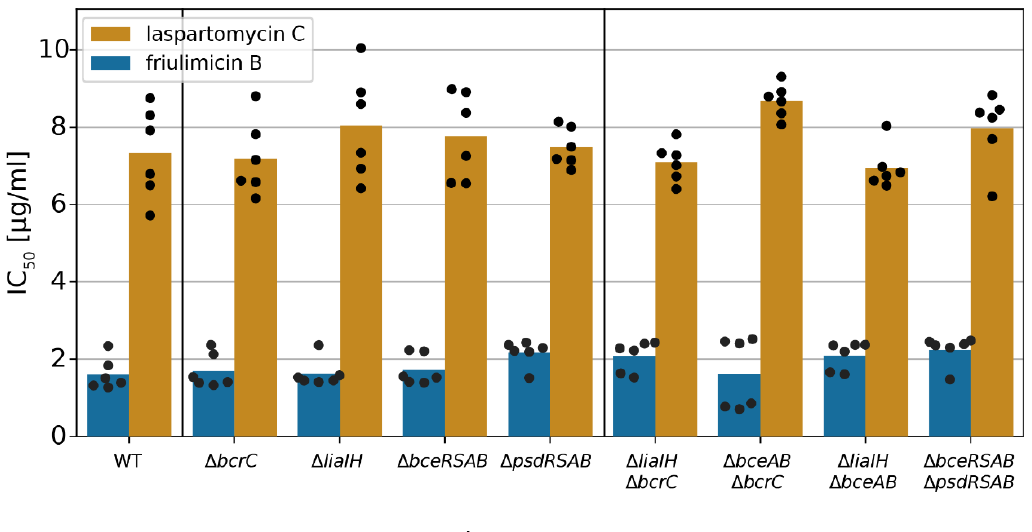
Figure 8. Impact of CESR modules on friulimicin B and laspartomycin C resistance. IC 50 values were measured 10 h after antibiotic challenge in wild-type B. subtilis and deletion strains of CESR modules. The IC 50 values of the wild-type strain were 1.6 and 7.3 μg/mL for friulimicin B and laspartomycin C, respectively. Bars represent the averaged IC 50 over six biological replicates. Black dots show single replicates. Neither deletions of single CESR modules nor the combination of any two deletions changed the IC 50 significantly (Student’s t-test: p > 0.001; unequal variance).